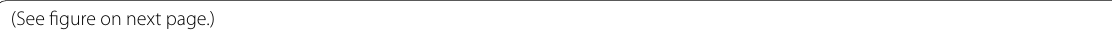
(See figure on next page.) Fig. 9 Effect of THC or CBD treatment on gut microbiota of mice fed HFCD. A Relative abundance of phyla. B Bacteroidetes to Firmicutes ratio. Relative abundance of C Clostridia, D Ruminococcaceae, E Bilophila , F Mucispirillum , G Schaedleri . Male C57BL/6J mice aged 7–8 weeks were fed either normal diet (ND, n 8), high fat 1%(w/w) cholesterol 0.5%(w/w) cholate diet (HFCD, n = + + n 8), HFCD containing THC (2.5 mg/kg) (HFCD THC, n 8). Bacterial DNA was extracted, and values were expressed as mean = + = marked with different letters (a, b) are significantly different ( p < 0.05) in the Tukey–Kramer